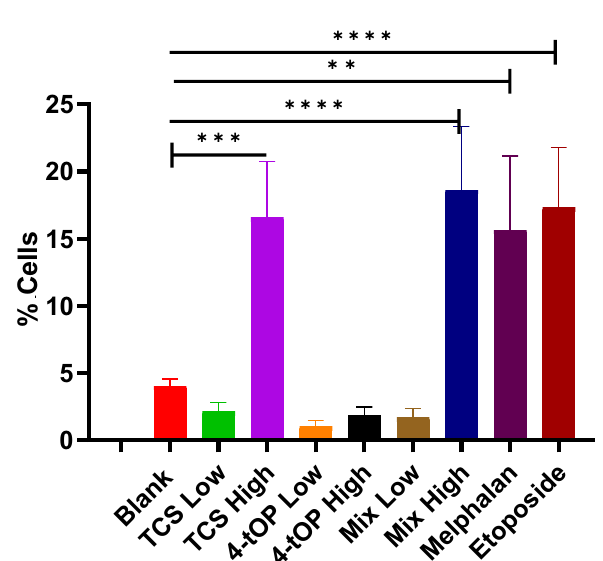
Figure 7. Proportion of cell death by apoptosis following treatments. p values *** = 0.0002, ** = 0.0006, **** = 0.0001, n =